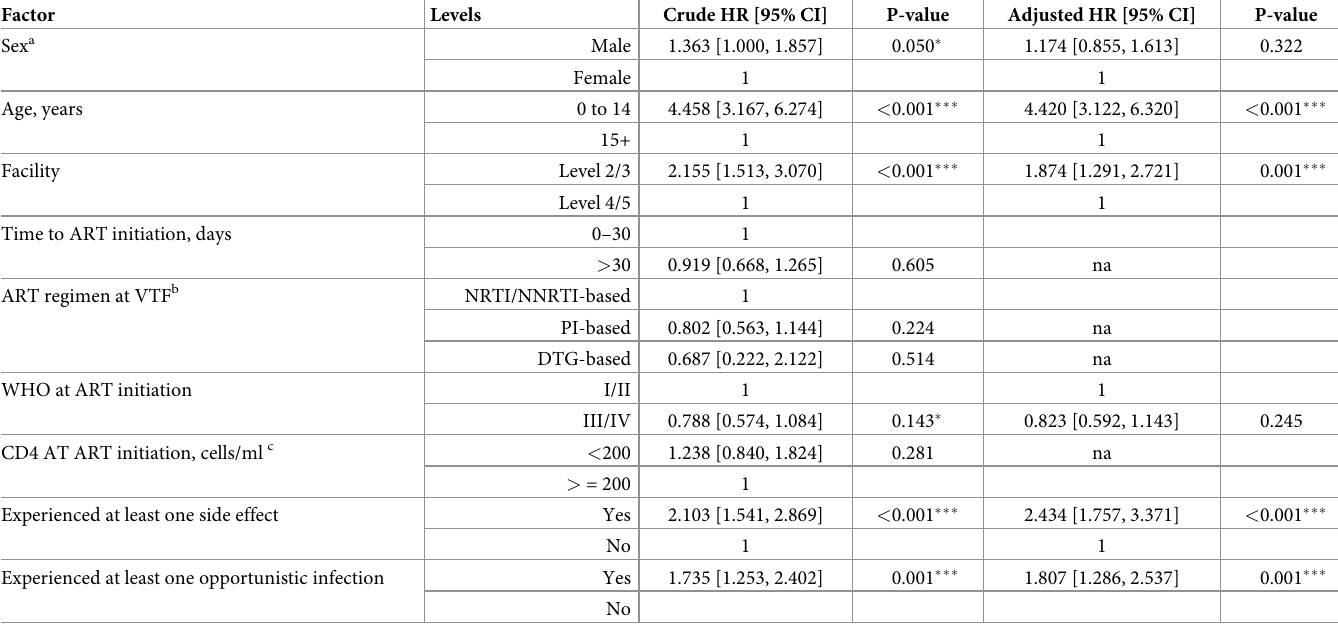
Table 3. Factors associated with confirmed